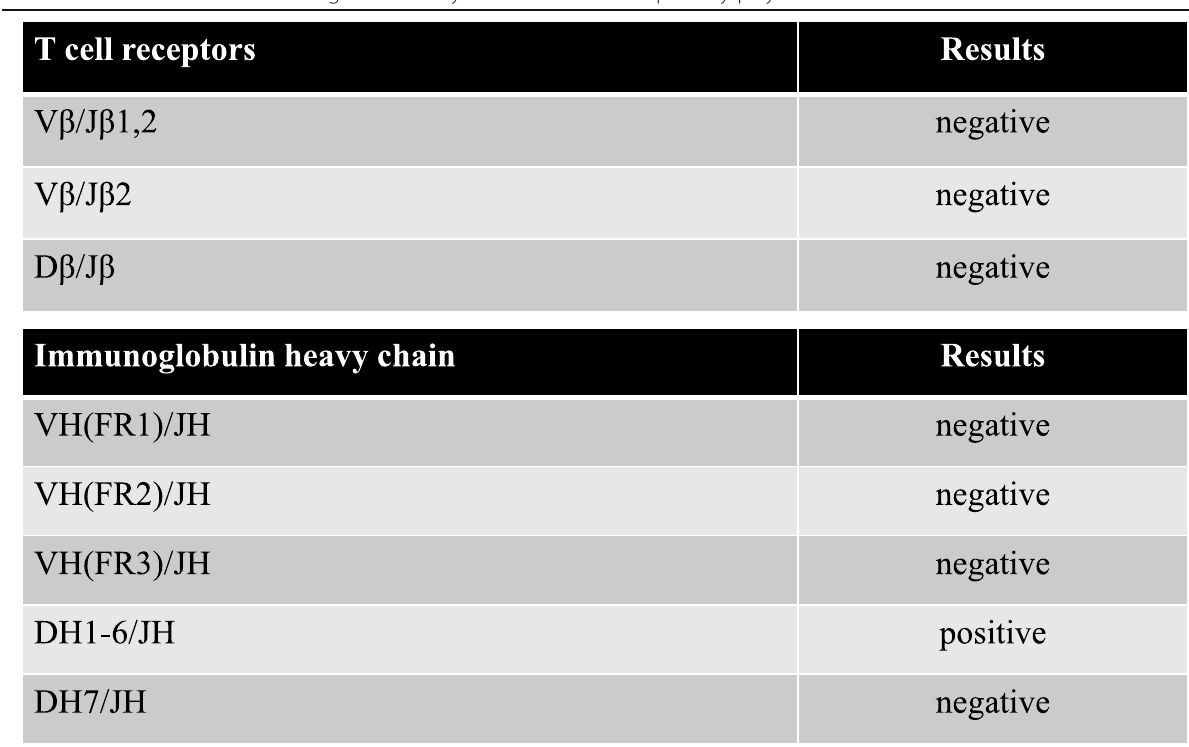
Table 1 Recombination of immunoglobulin heavy chain and T cell receptors by polymerase chain reaction